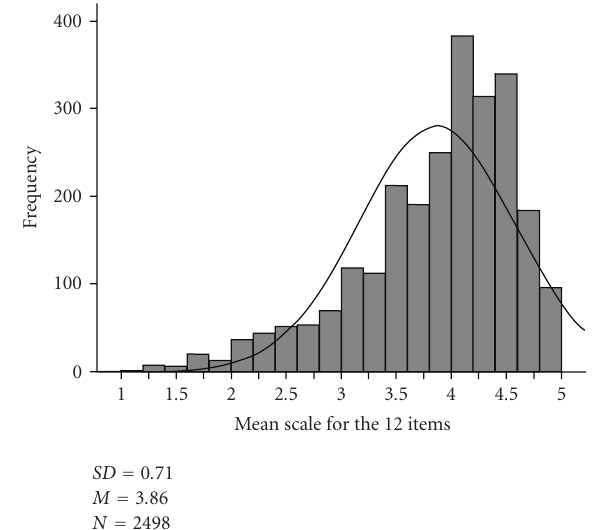
Figure 1: Frequency distribution of the individual mean scale for the 12